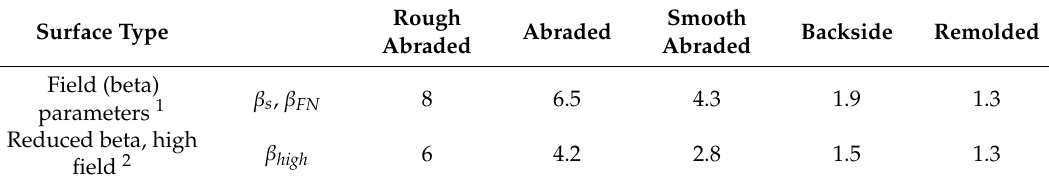
Table 3. Surface specific injection